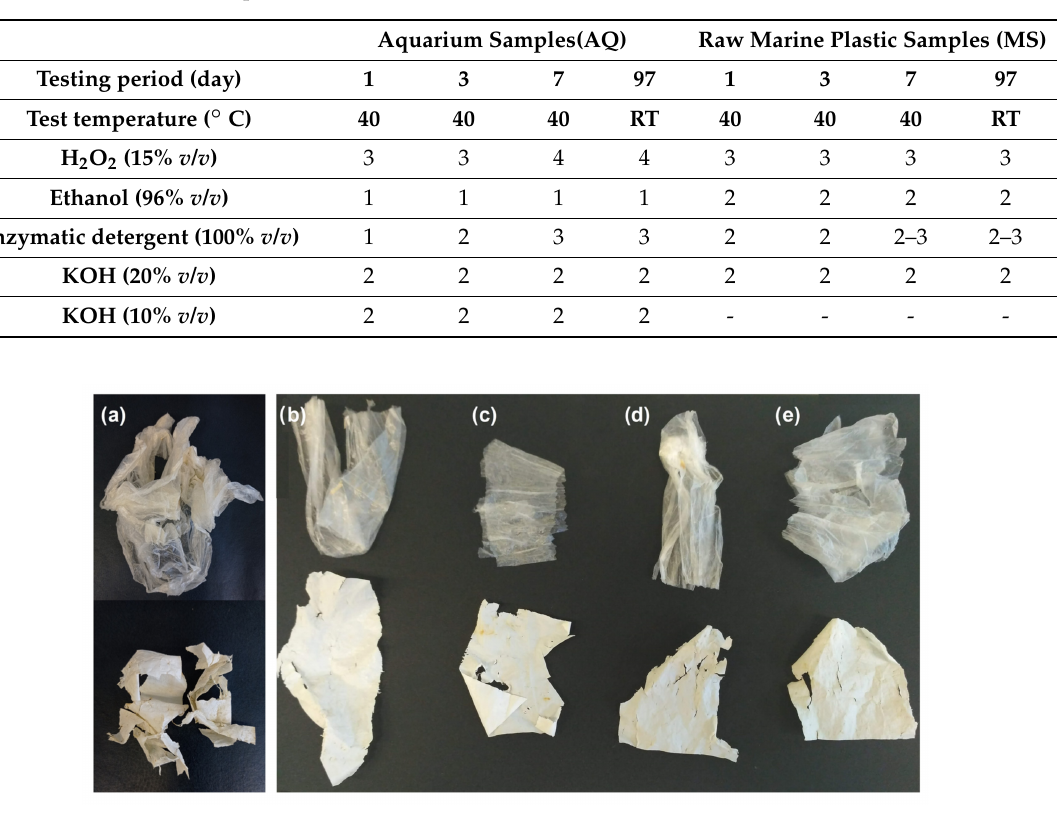
Table 1. Results of the visual inspection of organic matter and biofouling removal for the AQ and MS tests. Scale 1 → 4 refers to the degree of removal of organic matter and biofouling in the samples: 1: no changes, 2: little elimination, 3: high elimination, 4: total elimination. (‘-‘ test not performed).